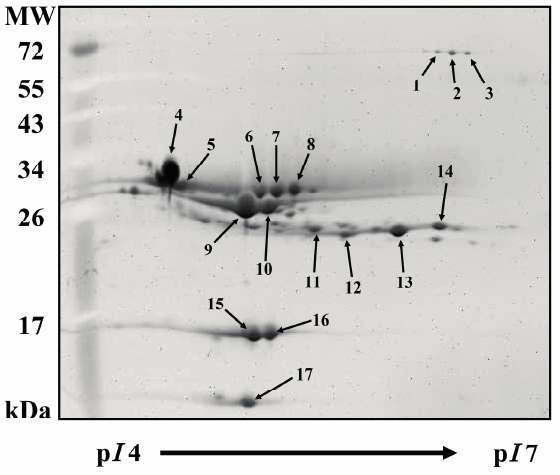
Figure 3. Two-dimensional polyacrylamide gel electrophoresis image of milk proteins. The sample was separated on a 12.5% SDS-PAGE gel using IPG strips (pH 4–7). The arrows indicate protein spots that were analyzed in this study. MW: molecular weight; p I : isoelectric point. Spots 1 to 3 were isomers of BSA, spots 4 and 5 were isomers of α S1 -CN, spots 6 to 8 were isomers of α S2 -CN, spots 9 and 10 were isomers of β -CN, spots 11 to